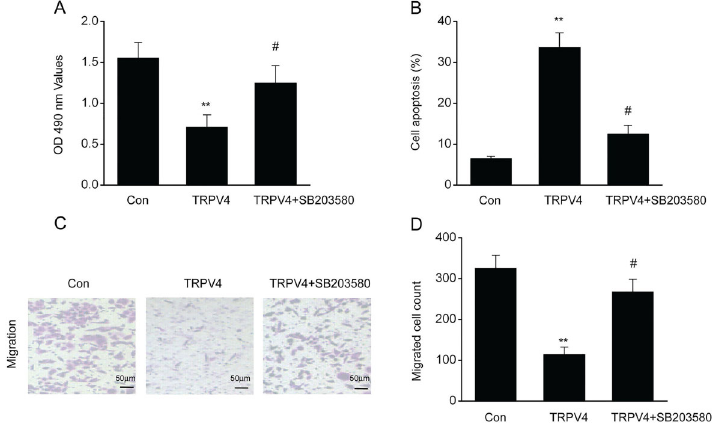
Figure 7. Effect of TRPV4 on lung cancer (LC) cells was eliminated by blocking the p38 MAPK pathway. LC A549 cells were supplemented with the p38 MAPK inhibitor SB203580 (10 m M) for 1 h and subsequently underwent 24 h transfection with either plasmid pcDNA3( + )/TRPV4 (TRPV4) or a control plasmid pcDNA3.1( + ) (Con). A , MTT assay was used to assess A549 proliferation. B , Flow cytometry was used to assess apoptosis. C , Images revealing migrated A549 cells on the bottom surface of the transwell membranes (scale bar 50 m m). D , Quantity of migrated A549 cells in 5 random fi elds under the microscope. Data are reported as means ± SE. **P o 0.01, compared to the control group, # P o 0.01, compared to the TRPV4 group